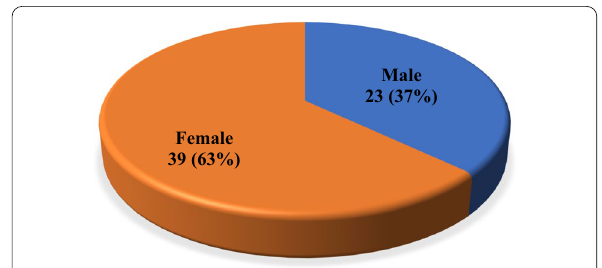
Fig. 1 Sex distribution pie for sino‑nasal mucormycosis